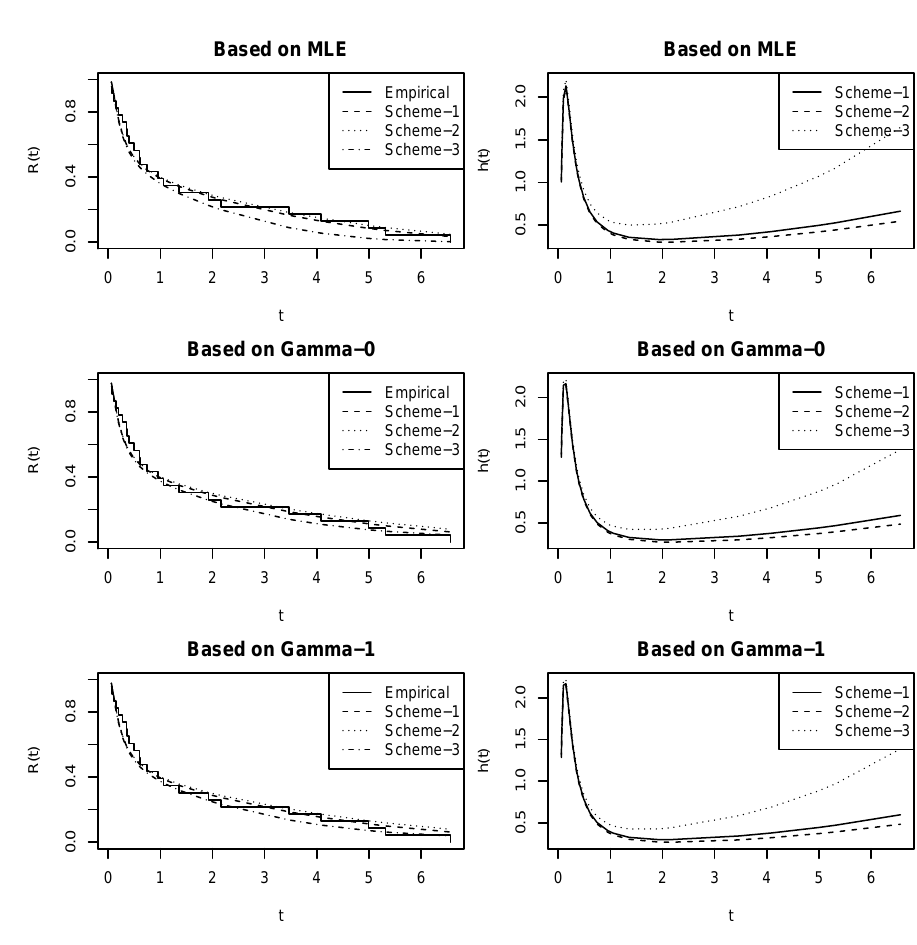
Figure 4 – Estimated reliability and hazard functions for real data set.